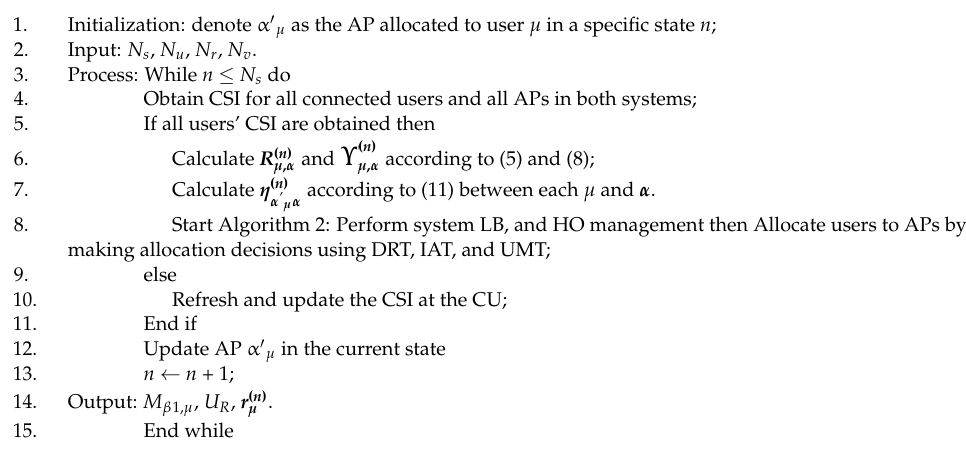
Algorithm 1 The proposed TPHM-APT executed by the CU